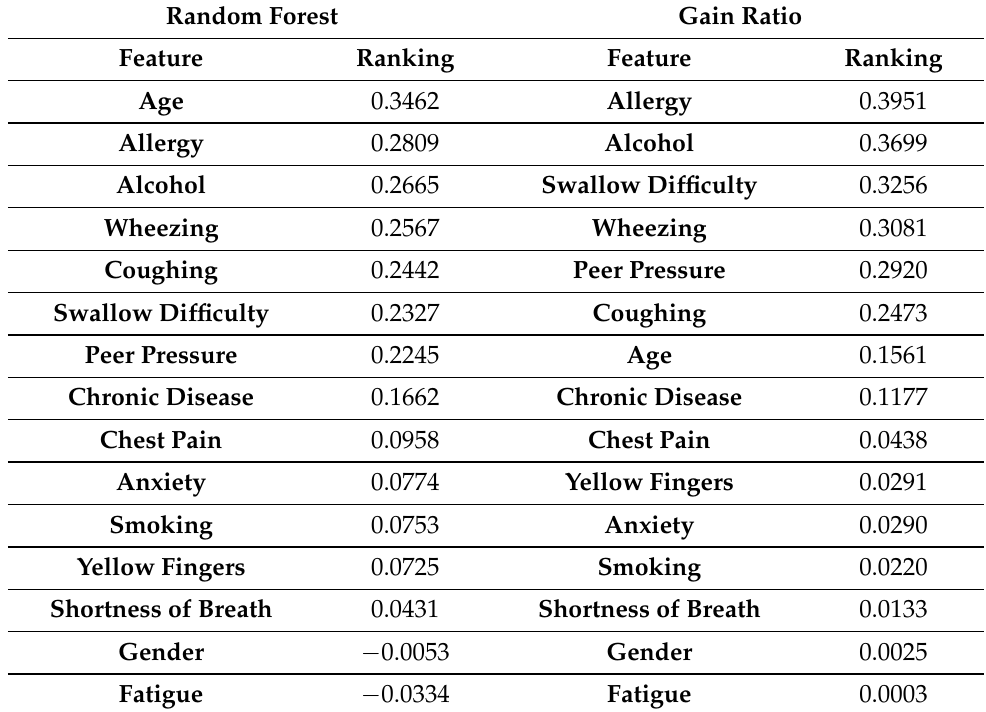
Table 1. Features’ ranking in the balanced